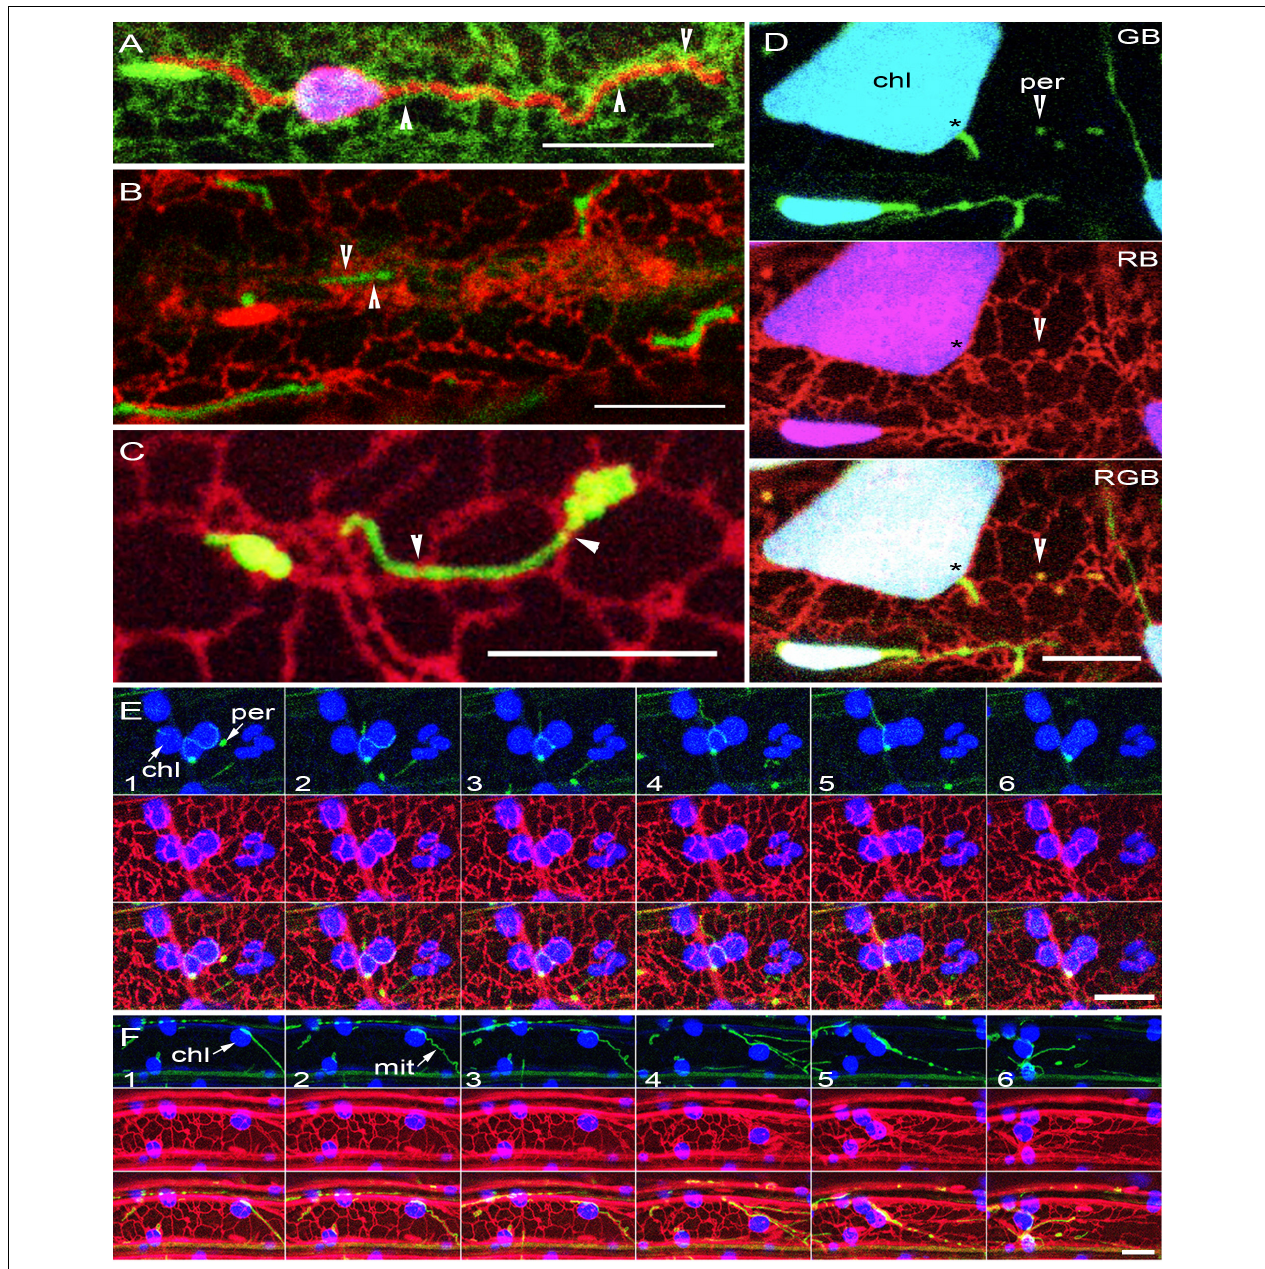
FIGURE 4 | Organelle extensions and tubular forms maintain connectivity only with the ER. (A) Plastid extension highlighted by OEM targeted expression of SFR2mRFP (red) enmeshed in the ER (green). Note the ER bands encircling the tubular extension (arrowheads). (B) Elongated mitochondria (green) in the Arabidopsis elm1 mutant enmeshed in the ER (red) through the ER encircling the tubules at different points (arrowheads). (C) GFP-labeled peroxisomes in the Arabidopsis apm1 mutant enmeshed in the ER (red) with main contact points indicated by arrowheads. (D) A single snapshot from image series shows large chloroplasts in the Arabidopsis arc6 mutant with extensions (*), highlighted using a stroma targeted tpFNR-EGFP and observed with peroxisomes (yellow -arrowheads), both enmeshed independently by the ER (red). Chlorophyll depicted in blue (B), GFP in green (G), RFP in red (R); Yellow color of peroxisomes detected by overlapping R and G fluorescence. (E) Six sequential images showing an elongated green fluorescent peroxisome (per) in the Arabidopsis apm1 mutant along with red fluorescent ER and chloroplasts (chl- blue). Note the close association between the peroxisome and the peri-plastid ER which allows the peroxisome to appear close to and molded around the chloroplasts. (F) Six sequential images from a time lapse series ( Supplementary Movie 7 ) of elongated mitochondria (mit) in Arabidopsis elm1 mutant appearing closely appressed to the chloroplast (chl- blue) as both organelles relocate in tandem with changing ER (red) organization. Scale bars = 10 µ